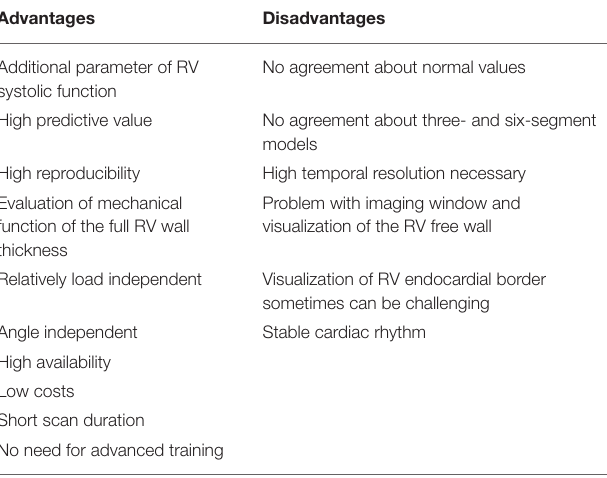
TABLE 1 | Advantages and limitations for evaluation of RV longitudinal strain.